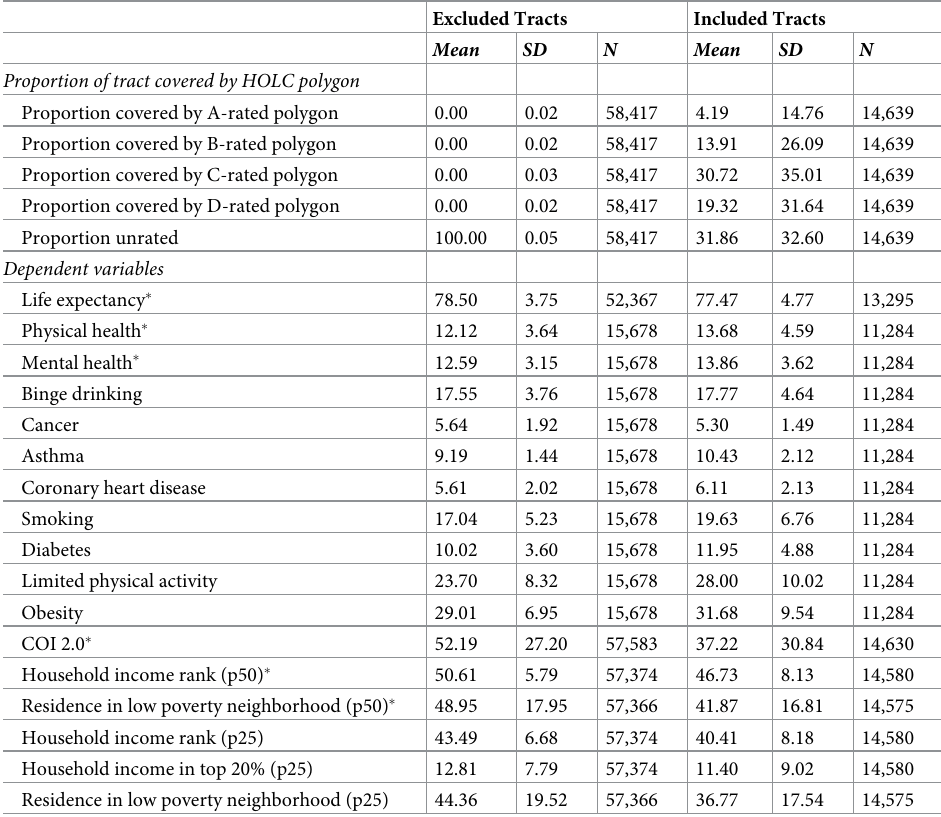
Table 2. Descriptive